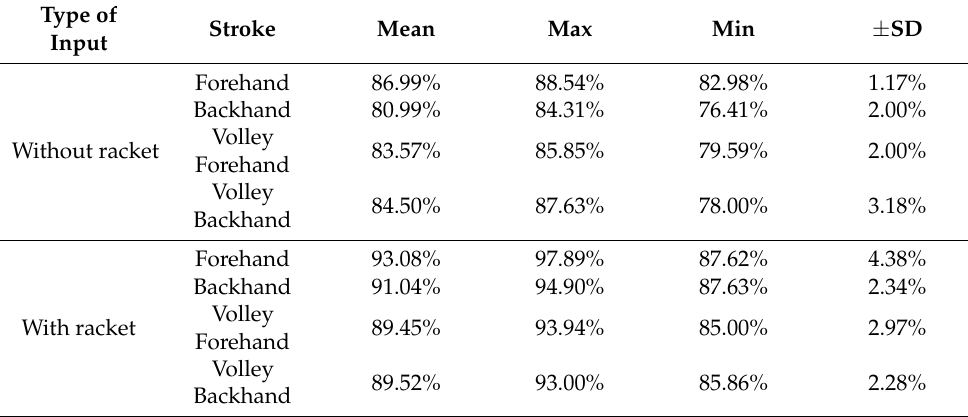
Table 3. Obtained Precision results.